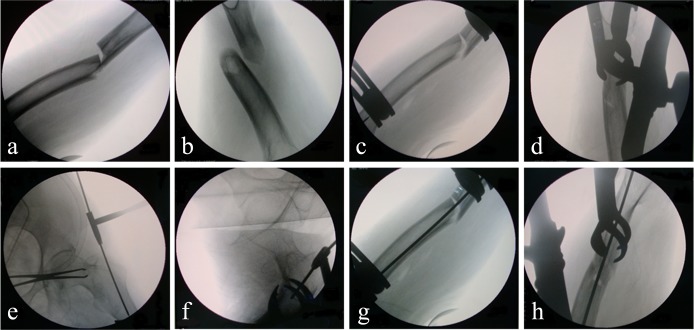
Radiographs showing application of the instrument in an operation for a femoral shaft fracture.(a, b) preoperative condition of the fracture (c, d) completed closed reduction with fracture reduction device (e, f) drilling into the proximal femoral medullary cavity using a Kirschner wire (1.5 mm) through the short sleeve (g, h) drilling into the distal femoral medullary cavity using a Kirschner wire.